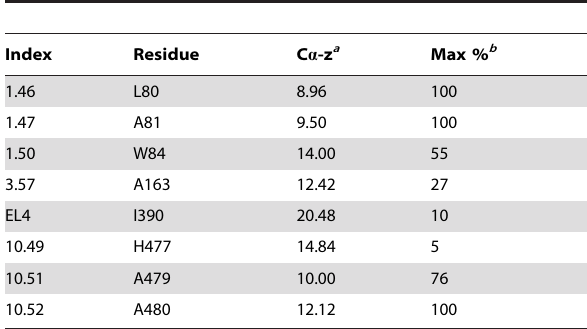
Table 3. The substrate translocation pathway from the S1 site to the S2 site.